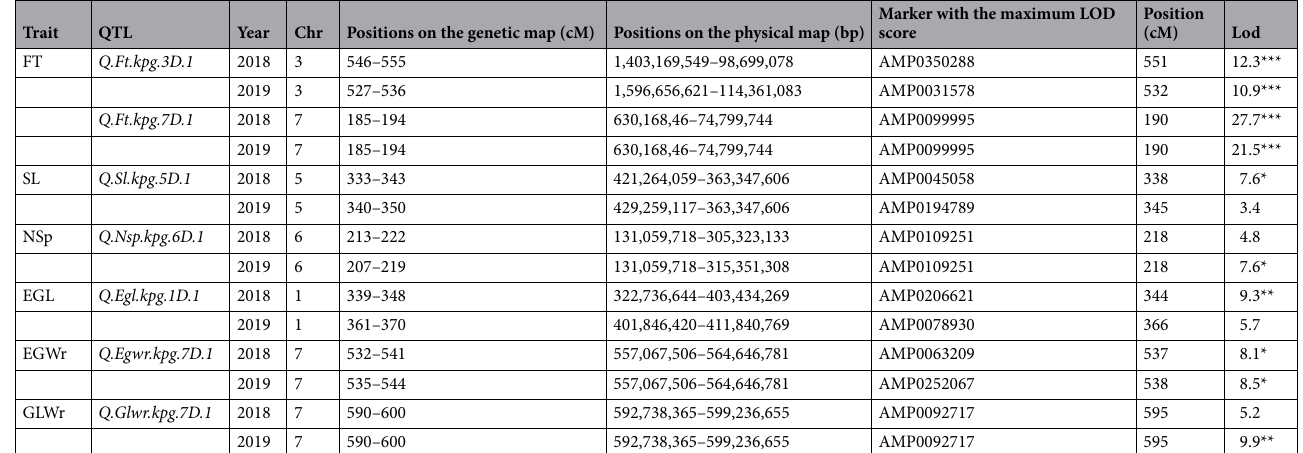
Table 1. Summary of LOD scores of the stable QTLs for traits in the two seasons. Positions of the physical map corresponded to positions of minimum and maximum bp of GRAS-Di markers that were located within QTLs (cM). Positions on the genetic maps included not only GRAS-Di markers but also markers that were estimated by the software r/qtl (Broman et al. 2003). The orders of some GRAS-Di markers on the physical map were not consistent with those on the genetic map. For these reasons, the length of physical positions of QTLs was not always corresponding to that of genetic positions. Positions on chromosomes 2, 3, 4, 5 on the genetic map were inversely ordered with those on the physical map. *P < 0.05, *P < 0.01, ***P <